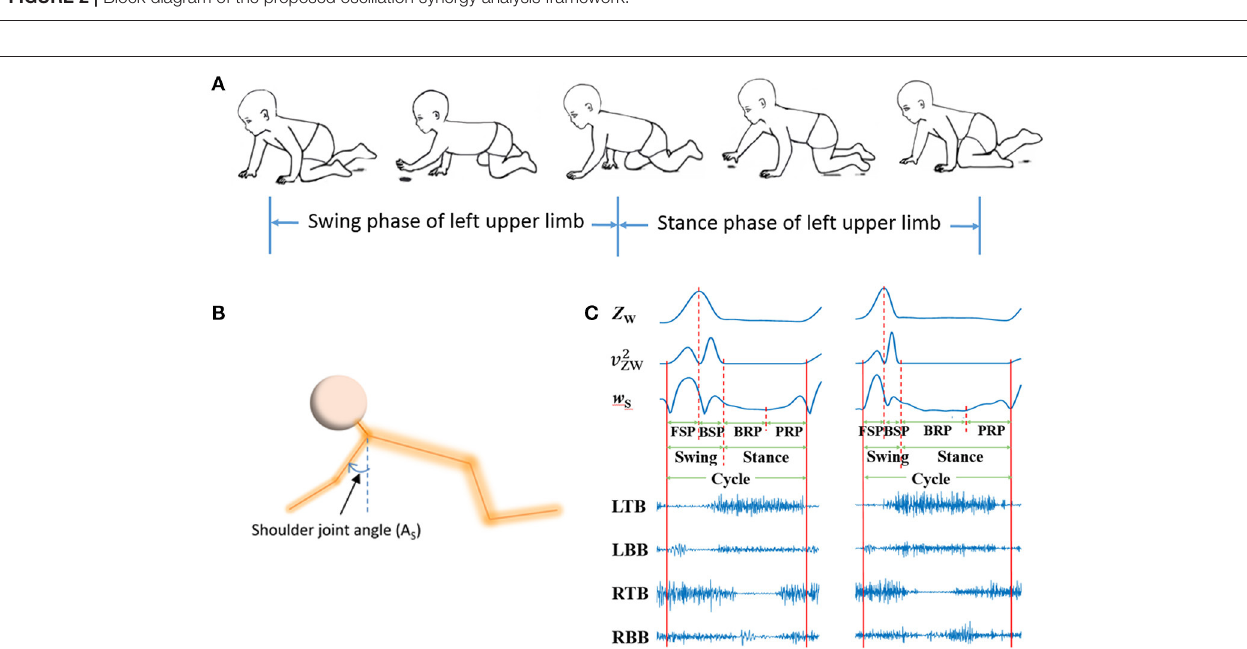
FIGURE 3 | sEMG and kinematic recorded in infant crawling. (A) Diagram of the crawling cycle of left upper limb [Adapted from Patrick et al. (33)]; (B) Schematic of the shoulder joint angle (AS); (C) Refined crawling phases, and the corresponding sEMG signals of bilateral TB and BB (LTB, left TB; LBB, left BB; RTB, right TB; RBB, right BB;) of one crawling cycle for TD (left graph) and CP (right